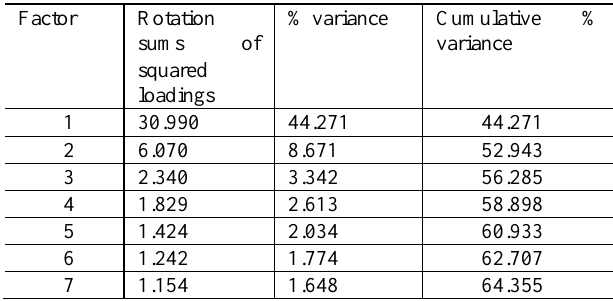
Table 3: Principle components factor analysis